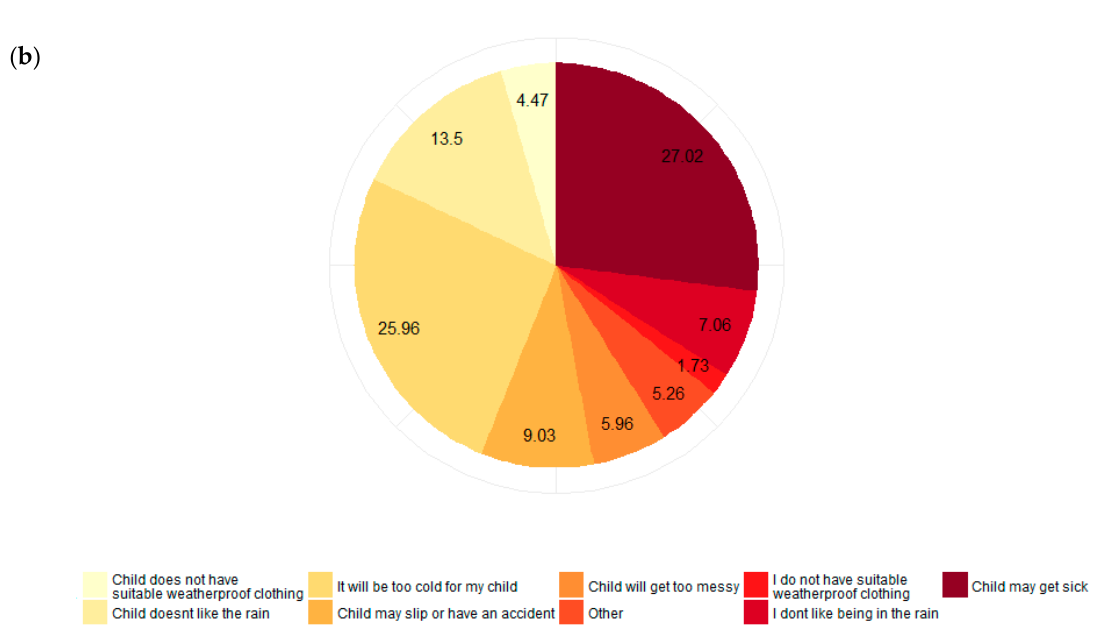
Figure 6. ( a ) Number of parents who allow their children to play in the rain (N = 1573) and ( b ) proportion of respondents agreeing with the suggested barriers. Respondents could mark as many options as they wished. All “yes” answers were summed (total = 3001) and the number per barrier calculated.